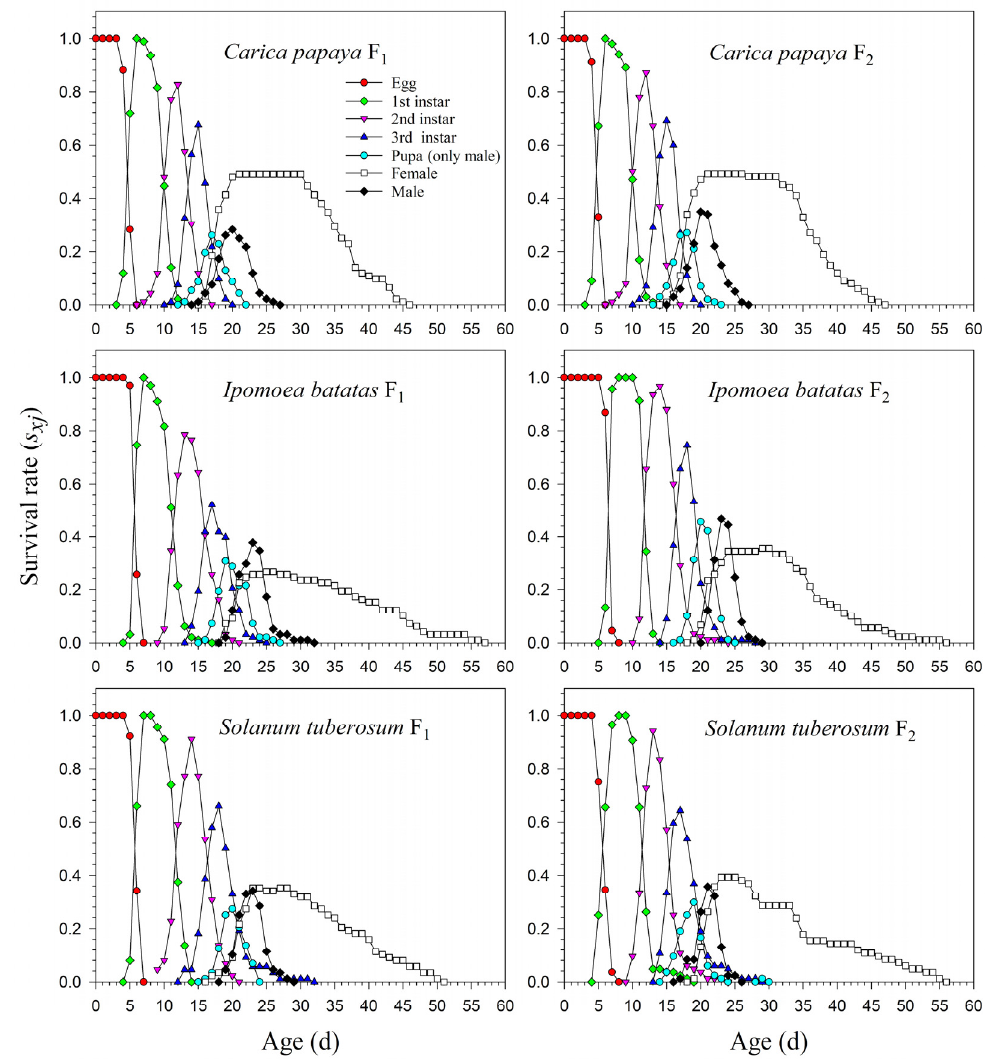
Figure 2. Age-stage-specific survival rates ( s xj ) of Paracoccus marginatus individuals reared on three different host plants (F 1 –F 2 ).